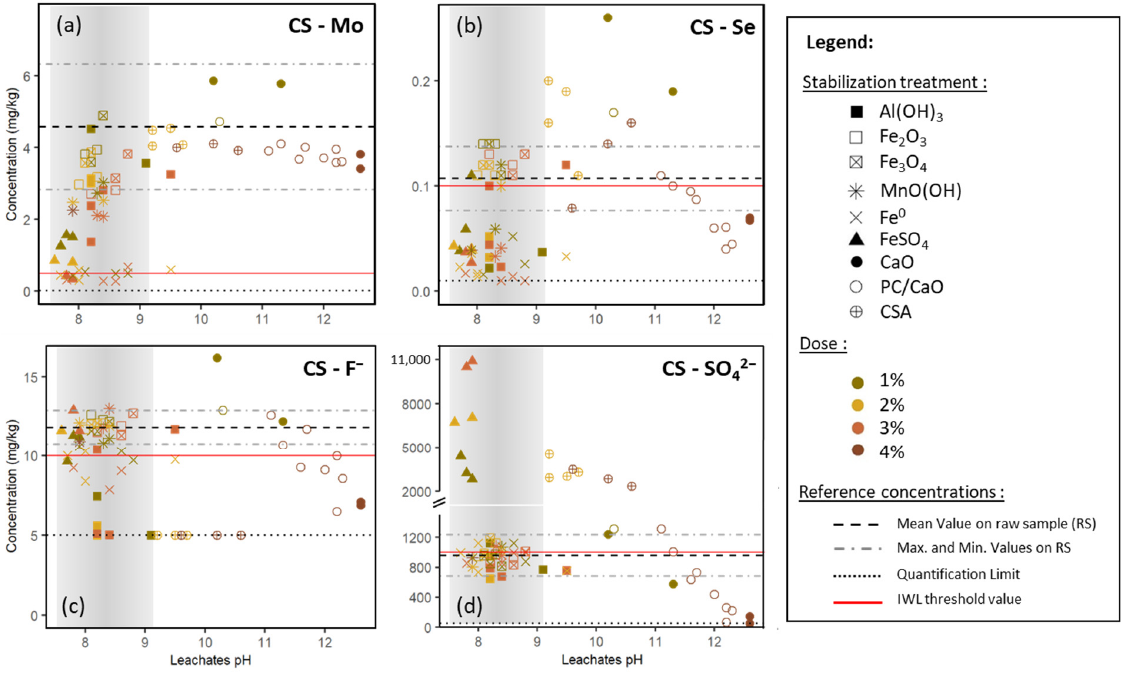
Figure 1. Mo ( a ), Se ( b ), fluorides ( c ) and sulfates ( d ) concentrations in the leachates of standardized leaching tests as a function of pH and of the stabilizing treatment in CS. Vertical gray areas represent the samples commonly observed natural pH. Attention has to be paid on the gap in the y -axis of CS-SO 42 − ( d ).